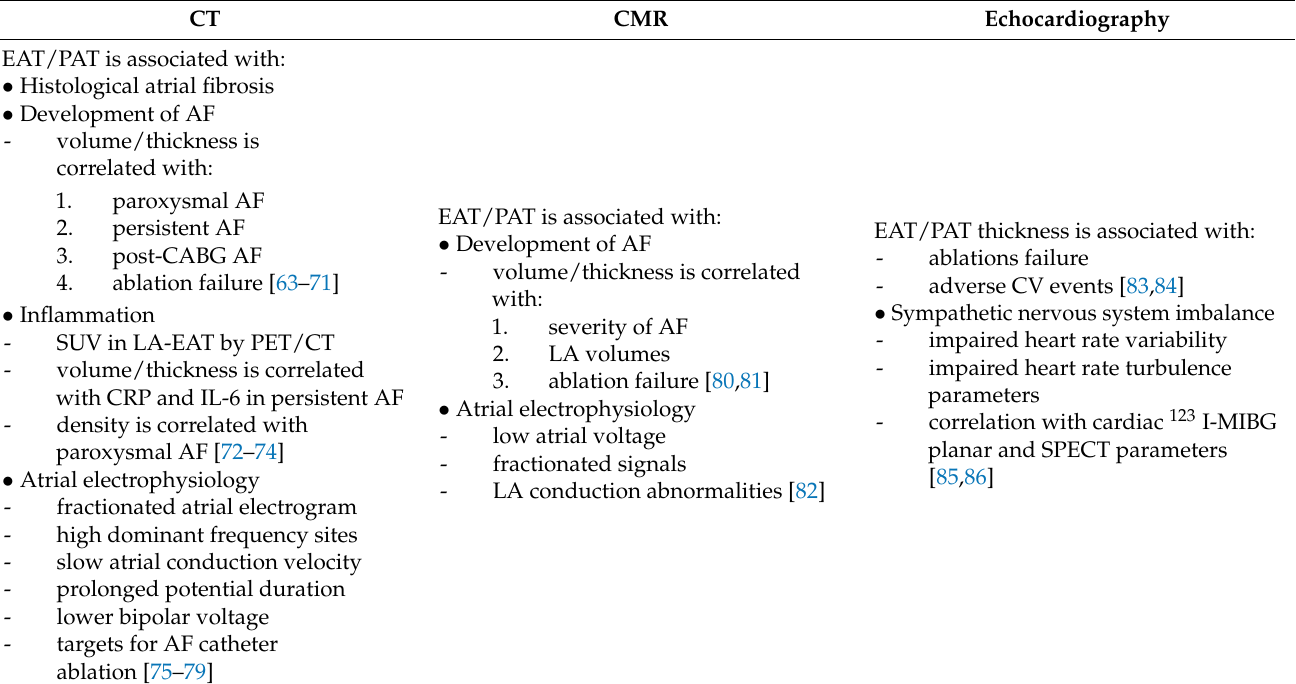
Table 2. Relationship between imaging measures of cardiac adiposity and AF.